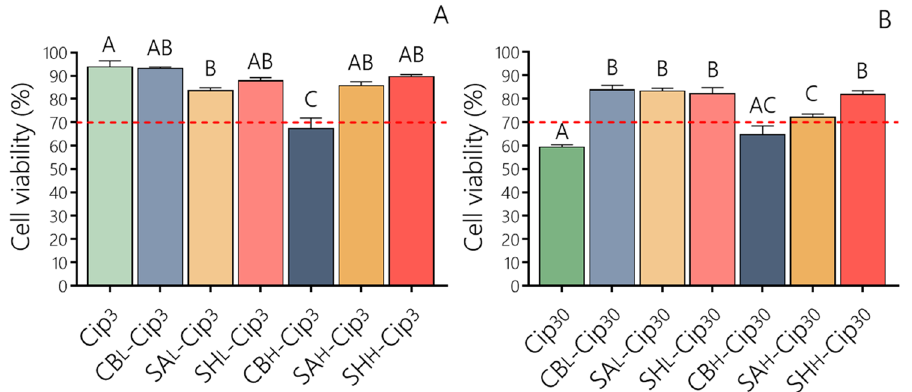
Figure 2. Cell viability of HDFs after 24 h of treatment with ( A ) Cip 3 and its complexes with PE L or PE H, and ( B ) Cip 30 and its complexes with PE L or PE H . The CV% was calculated according to Eq. (1). Values are expressed as the means ± their standard errors (n = 8). Differences between the treatments were evaluated by ANOVA and Tukey’s post-test (p < 0.05), with different capital letters above the bars indicating significant differences. The dotted line determines the cell viability limit allowed by ISO 10993 5 (CV ≥ 70%). Plotted with GraphPad Prism v.7.00 software (GraphPad, USA, https:// www. graph pad.